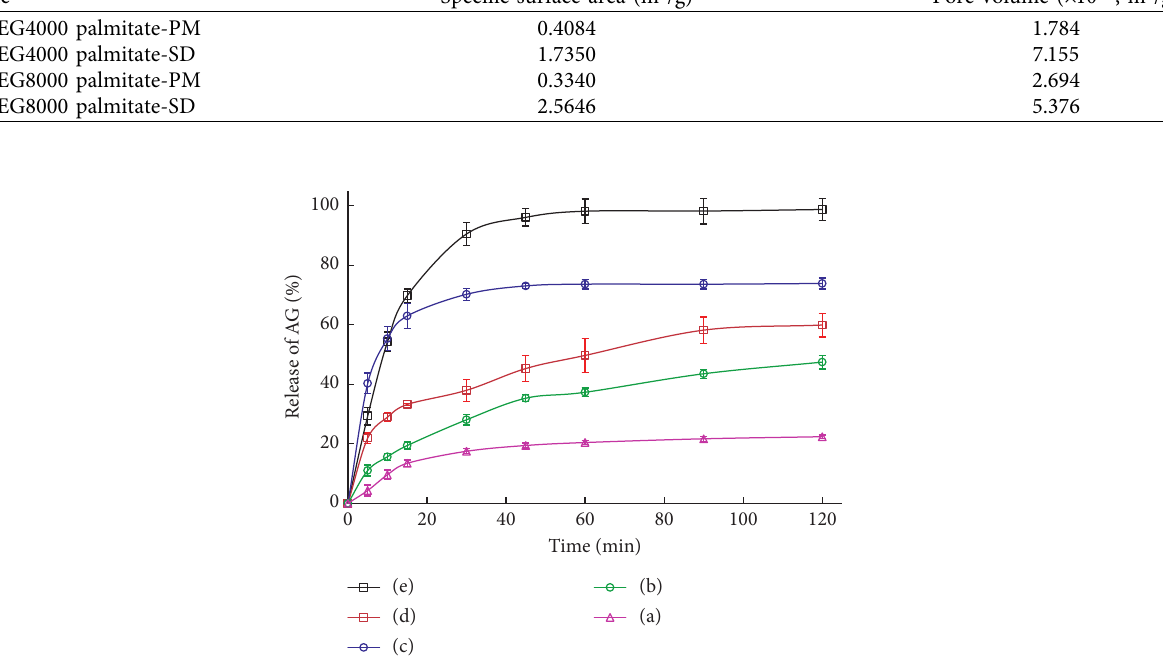
Figure 6: Dissolution profiles of (a) pure AG, (b) AG-PEG4000 palmitate-PM, (c) AG-PEG4000 palmitate-SD, (d) AG-PEG8000 palmitate- PM, and (e) AG-PEG8000 palmitate-SD. The error bars represent the standard deviation of measurements in six separate samples ( n �